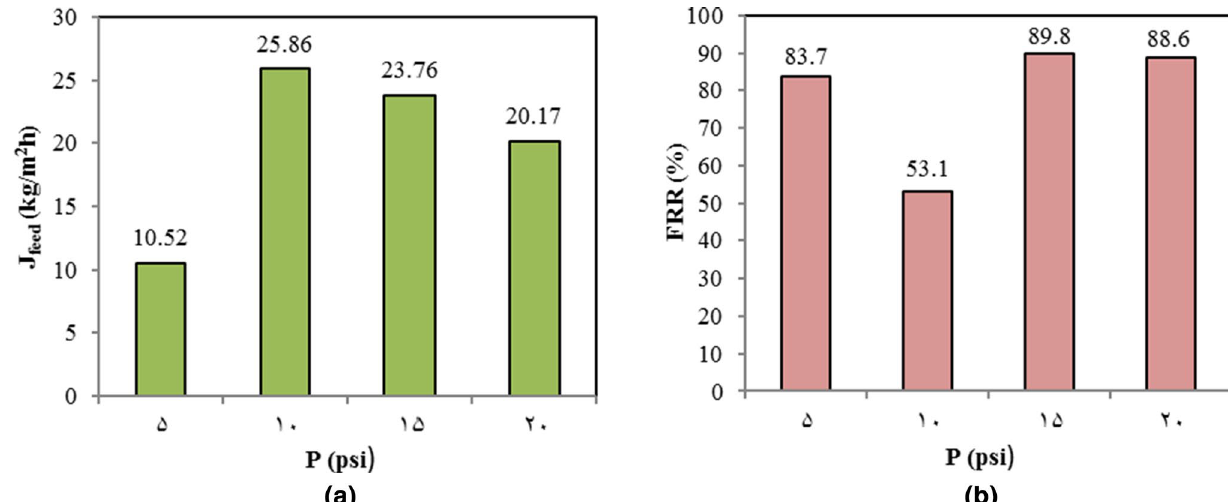
Fig. 6 J Feed ( a ) and FRR ( b ) measured for MF membrane at different pressures for soft drink wastewater (HRT = 12